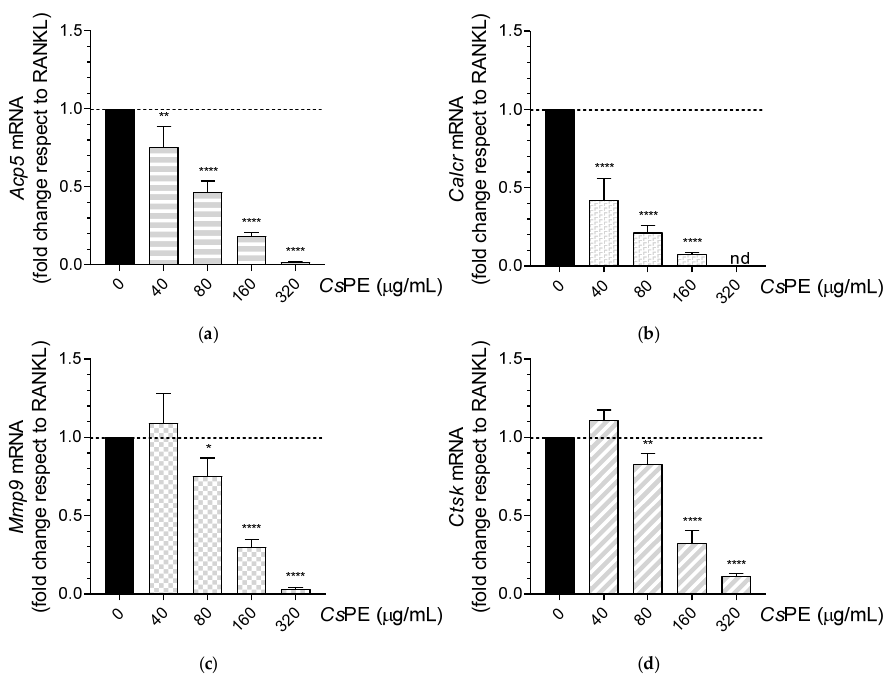
Figure 7. Down-regulation of marker genes of osteoclast formation and function in RANKL-differentiated RAW 264.7 cells treated with Cs PE. Real-time PCR analysis of ( a ) Acp5 , ( b ) Calcr , ( c ) Mmp9 , ( d ) and Ctsk transcripts in RAW 264.7 differentiated with RANKL and treated with the indicated concentrations of Cs PE. Gene expressions were normalized to the expression of Gapdh and reported as relative to the normalized expression in RANKL-differentiated control (black bar; dotted line, fold = 1); nd, not detectable. Data (mean ± SD) are the results of three independent measurements. * p < 0.05, ** p < 0.01, **** p < 0.0001, Cs PE/RANKL-treated versus RANKL-differentiated control (one- way ANOVA test).